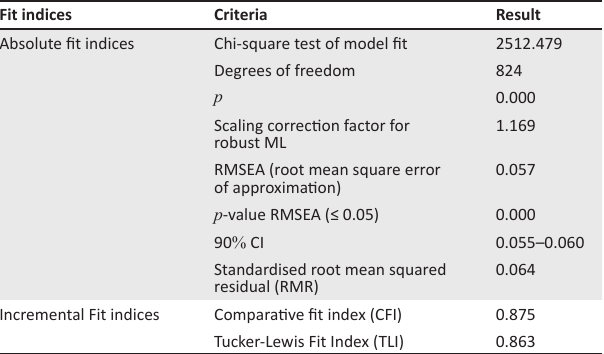
TABLE 2: Goodness-of-fit statistics for the structural model. Fit indices